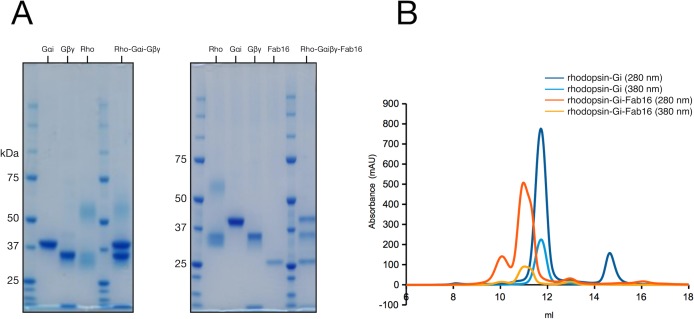
Purification of the rhodopsin-Gi and rhodopsin-Gi-Fab16 complexes.(A) SDS-PAGE analysis of individual proteins and main peak fraction of corresponding size-exclusion chromatography (SEC). (B) SEC profiles of rhodopsin-Gαi and rhodopsin-Gi-Fab16 complexes used for the preparation of cryo-grids.